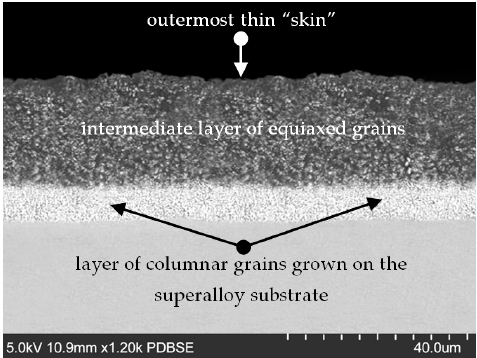
Figure 1. Example of an SEM image of a cross-section of the layer on as-coated blades prior to exposure to temperatures applied in this study.